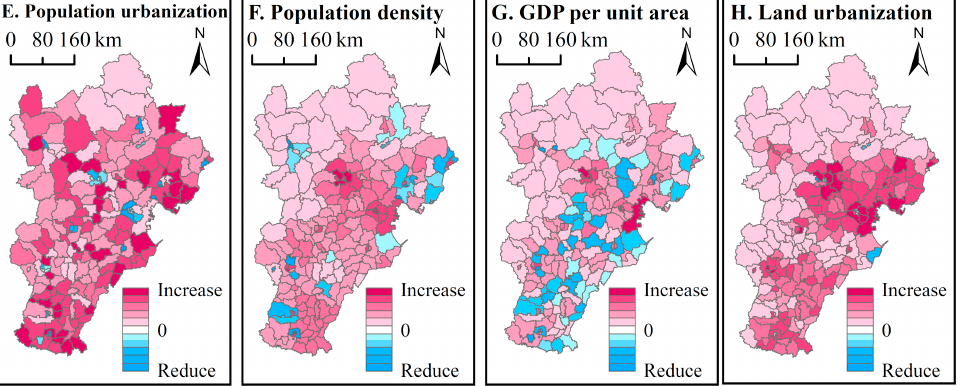
Figure 12. Development level and changes in county-level urbanization in the Beijing–Tianjin–Hebei urban agglomeration from 2000 to 2015. Note: Figure 12C is the current GDP in 2015, while Figure 12G is the difference between the actual GDP in 2015 based on the year 2000 and the current GDP in 2000.